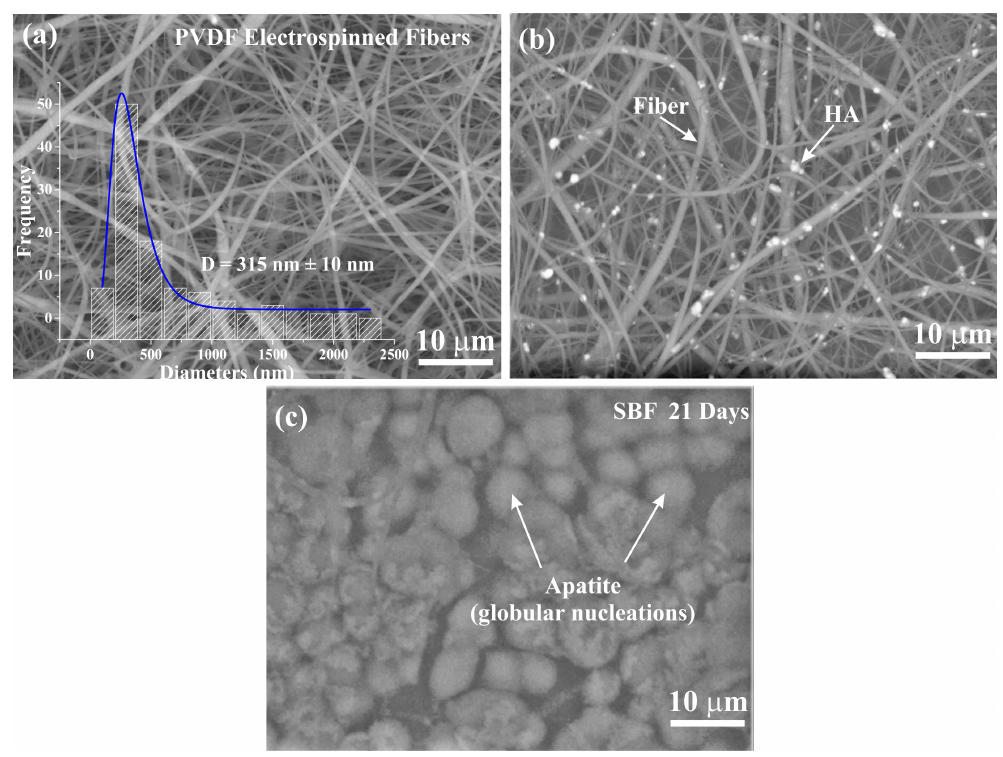
Figure 1. SEM images for ( a ) P14, ( b ) P14-H10 and ( c ) P14-H15 scaffolds (the image was obtained after immersion in SBF 21 days).